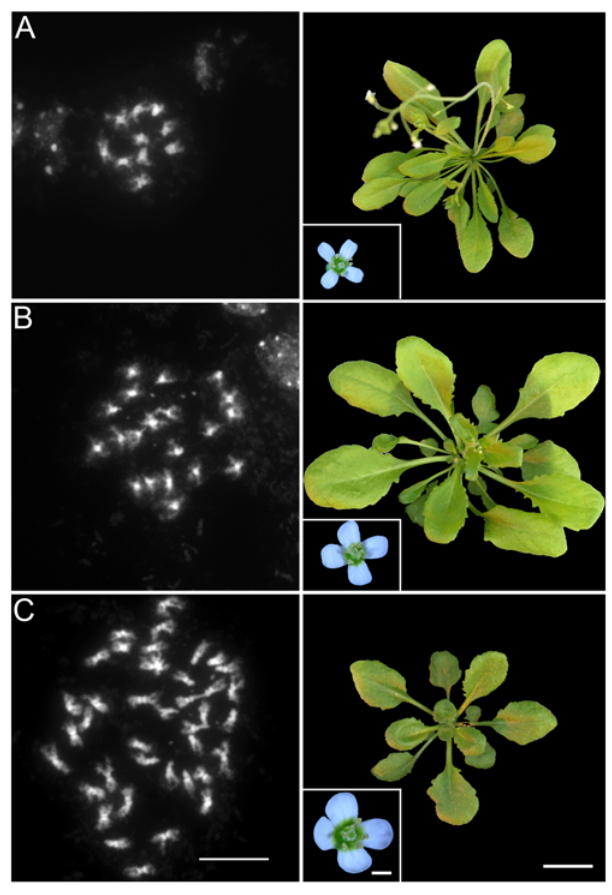
Figure 7. Doubling of ploidy at each generation in the MiMe line. In subsequent generations, MiMe plant ploidy doubled at each generation, from 2n (A) (10 chromosomes), to 4n (B) (20 chromosomes) and 8n (C) (40 chromosomes). The left column shows mitotic metaphase, scale bar=10 m m. The right column shows the corre- sponding four-week-old plants, (scale bar=2 cm) and flowers (scale bar=1 mm).